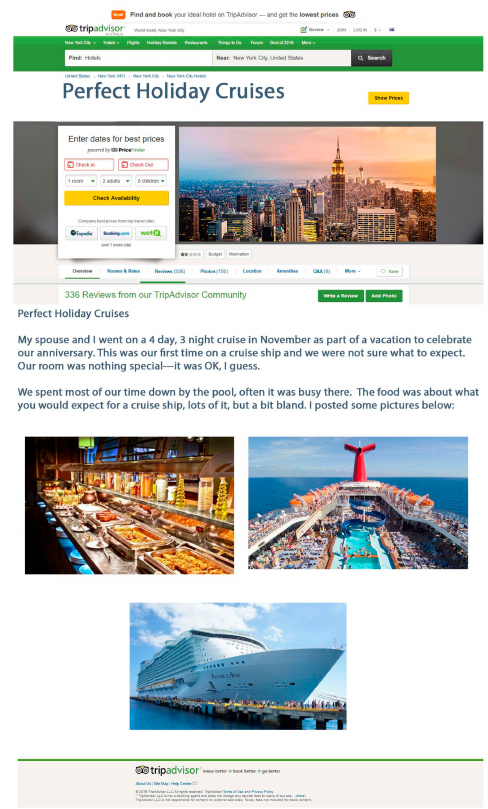
Figure A2. Cruise Ship, Neutral Review, Neutral